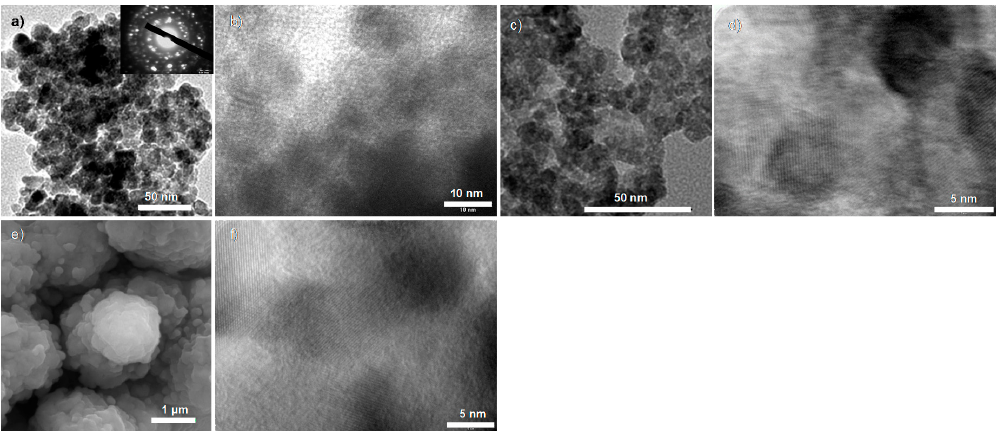
Figure 3. (High-resolution) TEM images of crystalline ( a , b ) ZnO -EtOH and ( c , d ) ZnO - i PrOH , and SEM and TEM image of ( e , f ) ZnO - n BuOH . The inset in ( a ) is the SAED pattern. As a comparison, thermal decomposition of intermediate Zn(O i Pr) 2 forms ZnO NPs composing of spherical agglomerations of crystallites. This result is quite similar to small-sized ZnO prepared previously via a hydrolysis of Zn(O i Pr) 2 [50]. In the present research, it is very difficult to perform the synthesis of strictly size-controlled and monodisperse ZnO NPs in the presence of stabilizer due to poor solubility and high concentration of intermediate Zn(OR) 2 formed in reaction system. This reaction system completely differs from that previously reported by Chaudret and co-workers for the synthesis of size- and shape-controlled crystalline ZnO NPs at room-temperature [51,52].